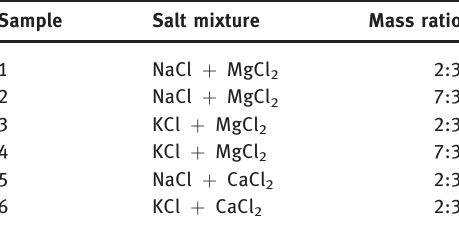
Table 2: Composition of the mixture chloride salts.